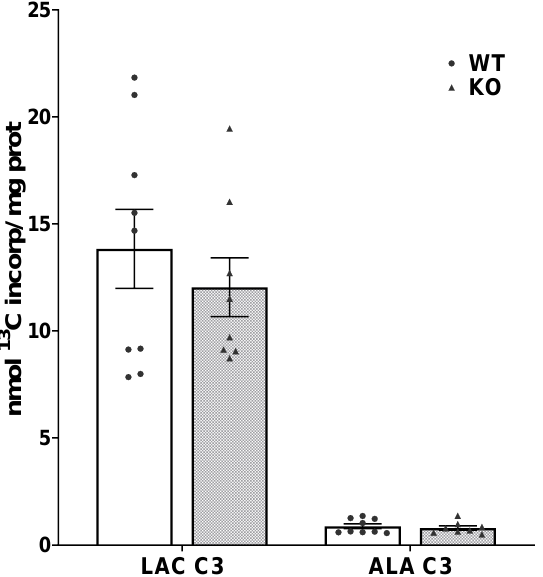
Figure 3. Incorporation of label from metabolism of [1,6- 13 C]glucose into newly synthesized lactate (LAC C3) and alanine (ALA C3) in brain from adult WT (white bars) and SIRT3 KO mice (gray bars). Values are mean ± SEM nmol 13 C incorporated/mg protein from n = 9 WT and 8 SIRT3 KO mice. Individual data points are indicated by circles and triangles. Data were analyzed by Student’s t-test; no differences were found.